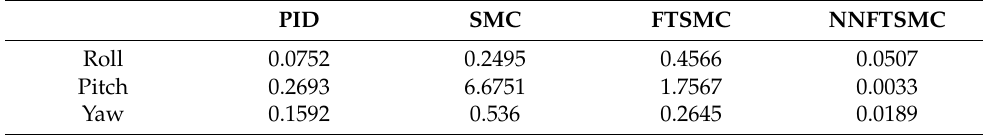
Table 5. The comparison of the simulation of attitude locking tracking results of